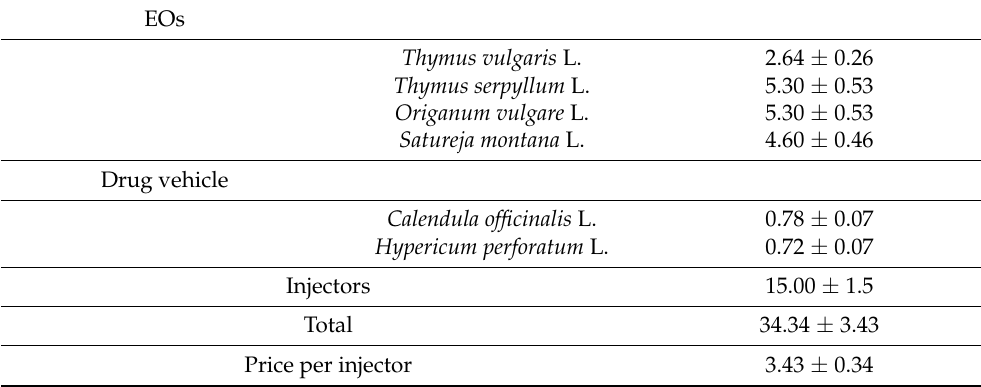
Table 4. The total cost of the Phyto-Bomat per cow expressed in euros (EUR). EOs